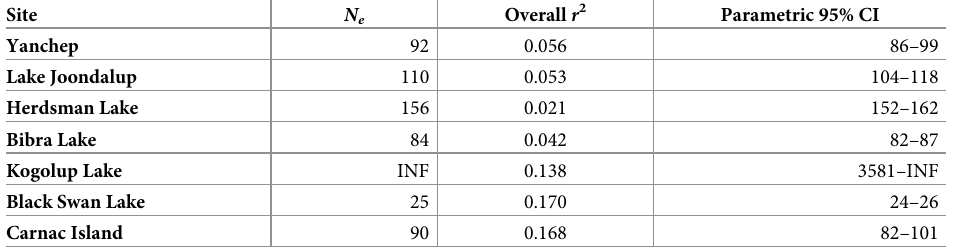
Table 3. Effective population size ( N e ) of seven populations of Notechis scutatus occidentalis around Perth, West- ern Australia. Site N